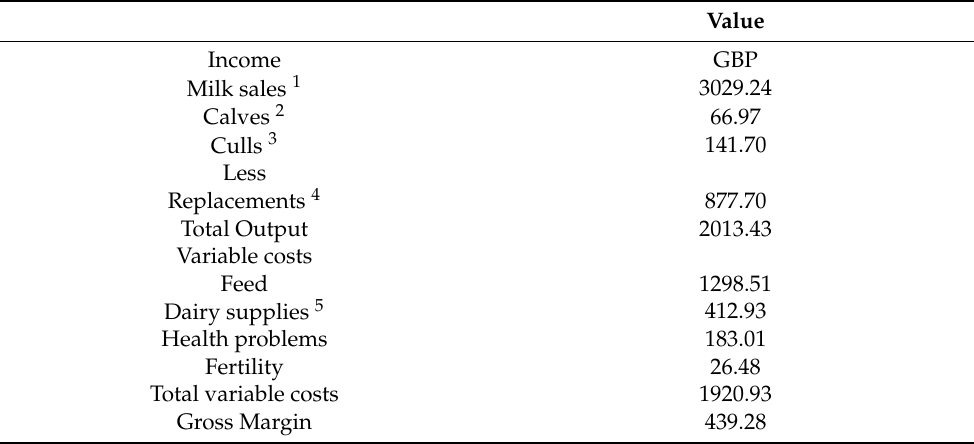
Table 2. Income and output costs (GBP) calculated for the herd per cow.